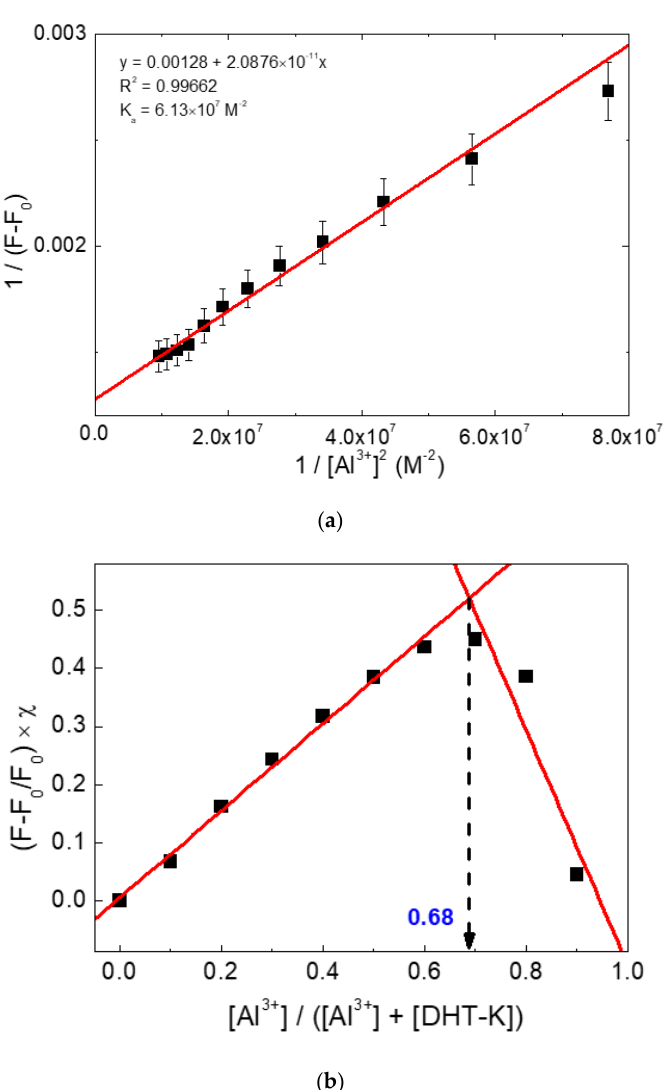
Figure 3. ( a ) Benesi – Hildebrand plot for determining the binding constant for Al ions; ( b ) Job’s plot for 1:2 complex formation of DHT-K and Al ions (χ: mole fraction of Al ions ). F 0 and F correspond to the maximum fluorescence intensity of DHT-K in the absence and presence of Al ions, respectively.